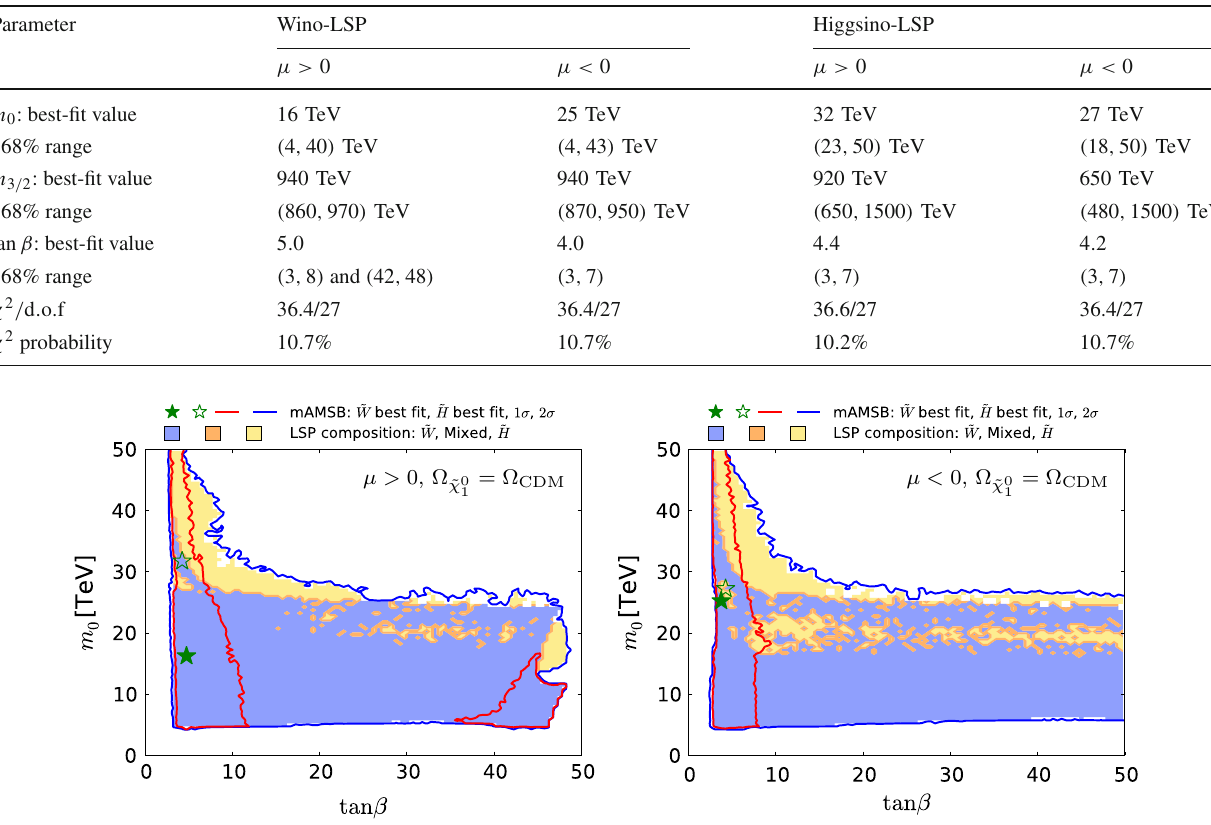
provides all the CDM density. The colouring 1